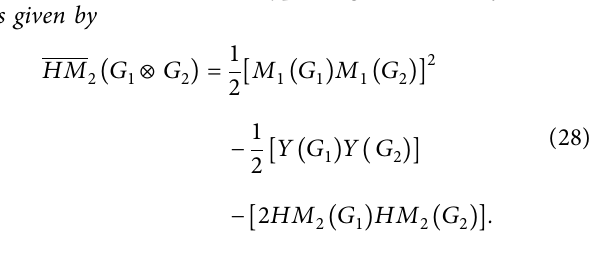
Figure 4: The molecular graph of a